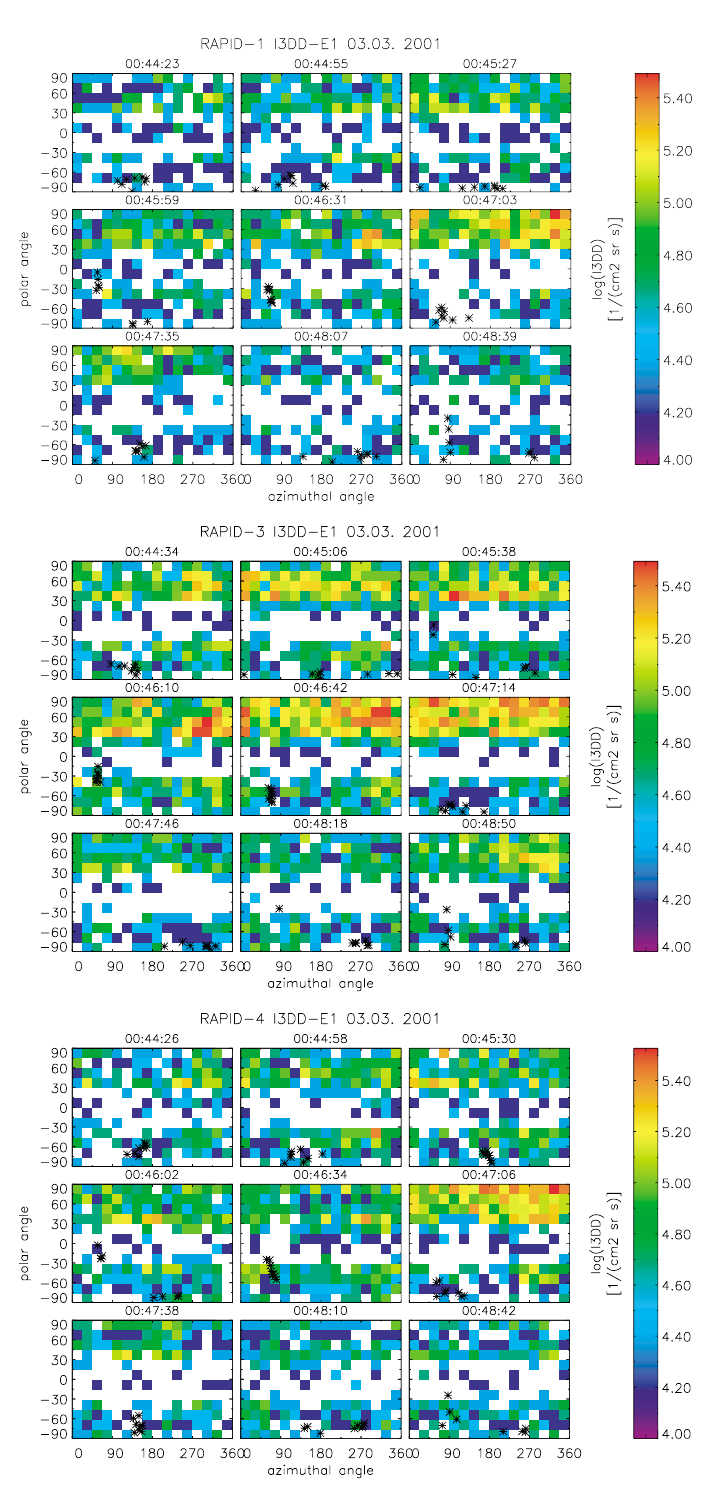
Fig. 10. Azimuthal-polar angle plots of proton ion fluxes, accumulated over 32s, observed by RAPID in the first energy channel (30–68keV) at the spacecraft 1, 3, 4. The asterisks show the corresponding angles of the spin averaged (4s) magnetic field.